Question: What caption would you write for this figure?
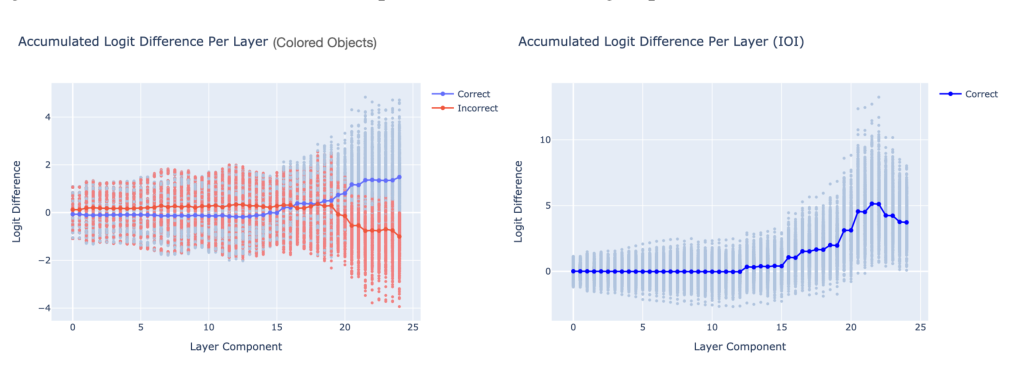
Answer: Cumulative logit attribution for both tasks. Here, higher is better: a positive logit differ- ence means the correct answer is more likely than a wrong answer. Measurements for each datapoint are shown as dots, while the average are depicted with lines. For each layer, a measurement of the next token prediction is taken before and after the attention layer. The final measurement is directly before the logits, thus giving us 49 layer components.